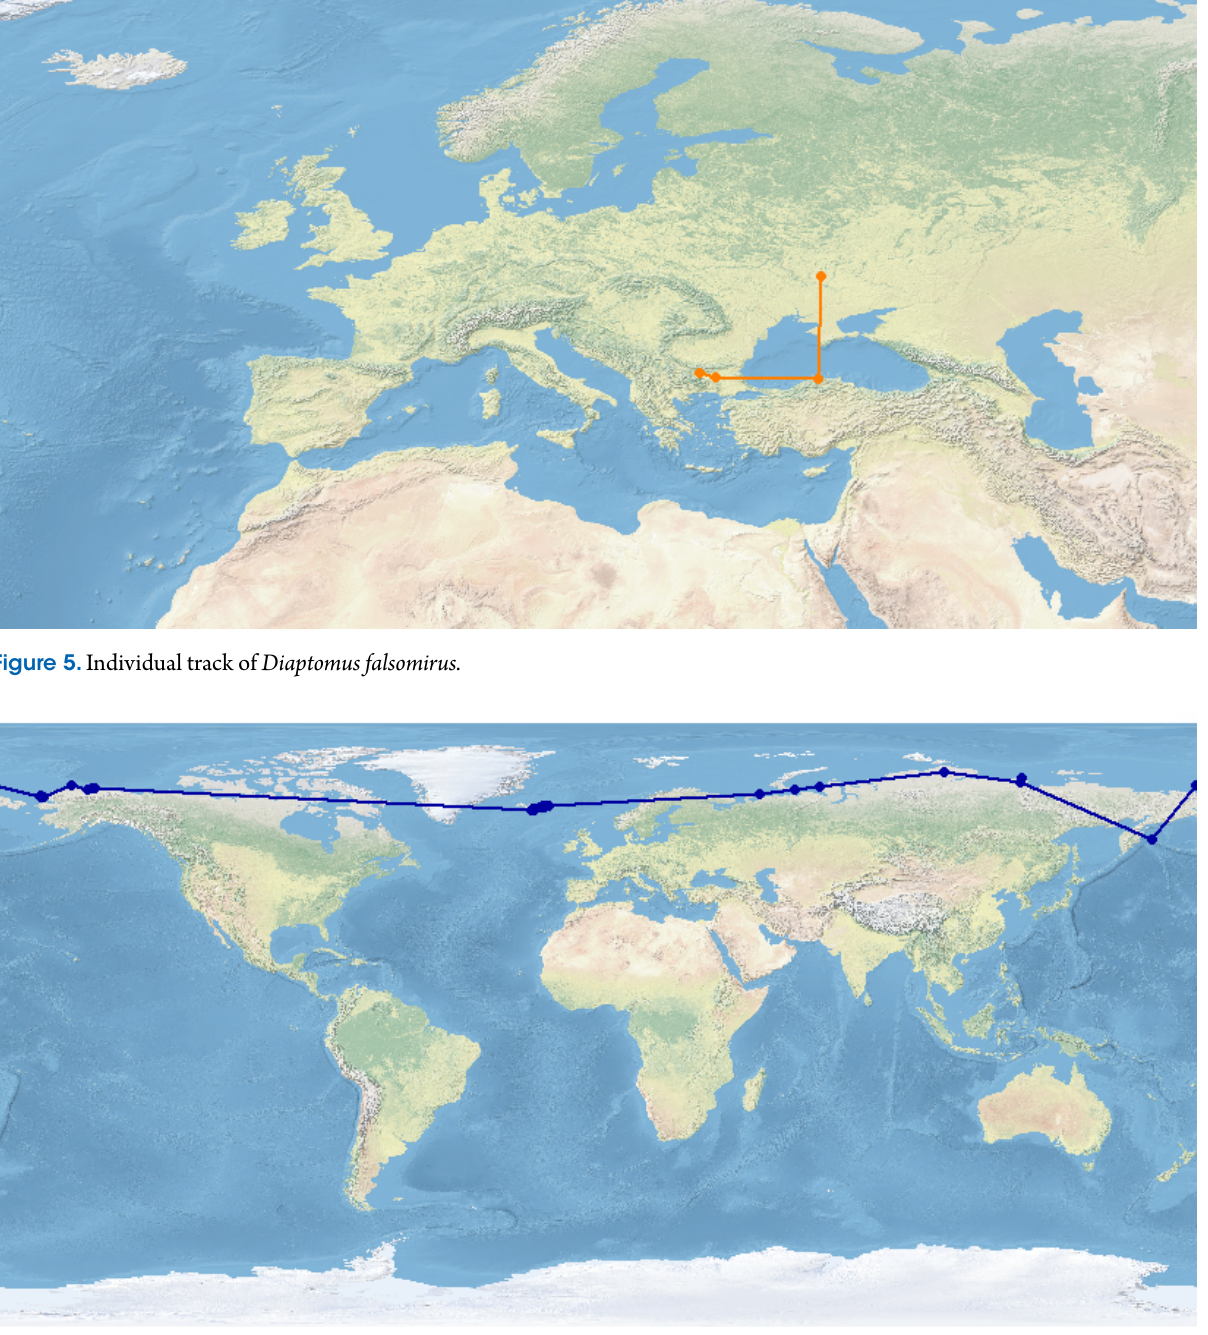
Figure 6. Individual track of Diaptomus